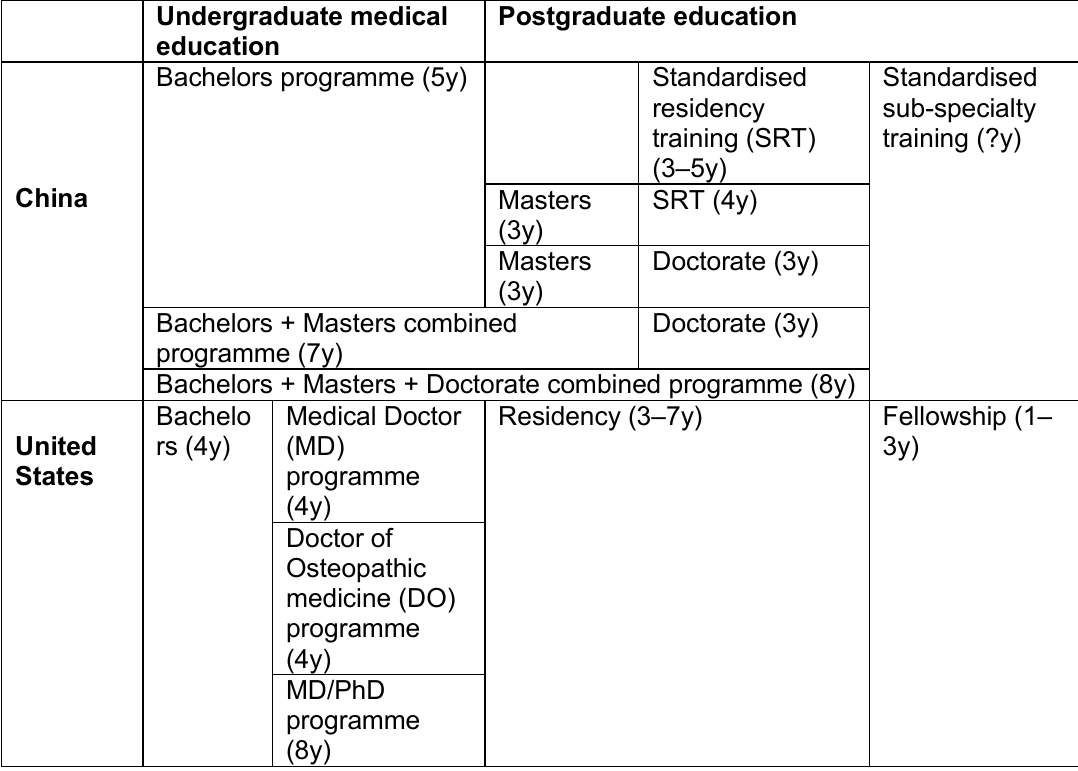
Figure 1. Stages of medical education in China and the United States. Figure created by the